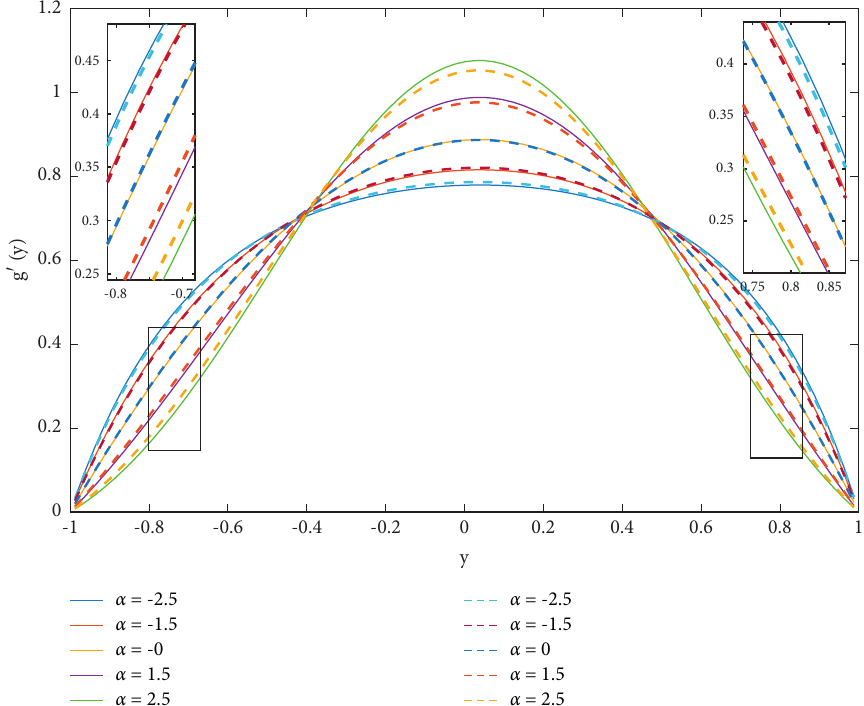
Figure 6: Impact of EC ratio α over the profile g ( 1 ) ( y ) for SWCNTs (concrete lines) and MWCNTs (dashed lines) via S2HWs for the parameters A ∗ � 0 . 2 , φ � 0 . 1 , R � 1.